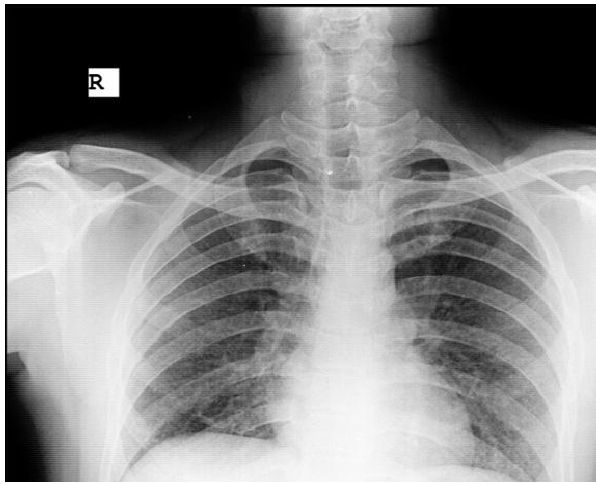
Figure 3: Chest X-ray six monts post-treatment.